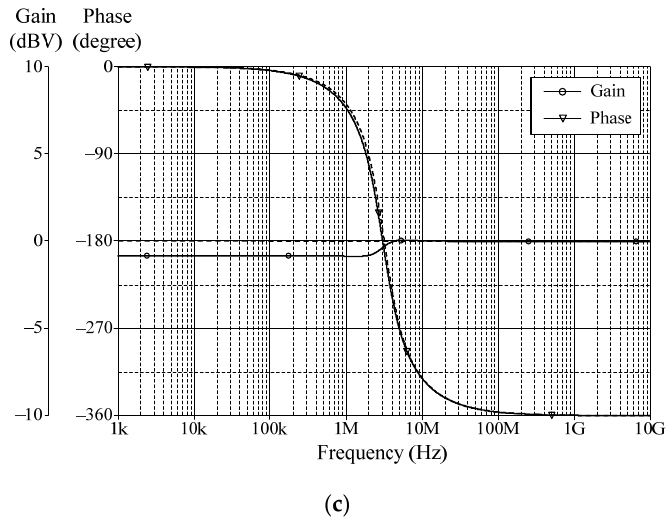
Figure 6. Frequency characteristics for VM (simulated in solid line, theoretical in dashed line): ( a ) LP, BP, and HP; ( b ) BS; ( c ) AP.